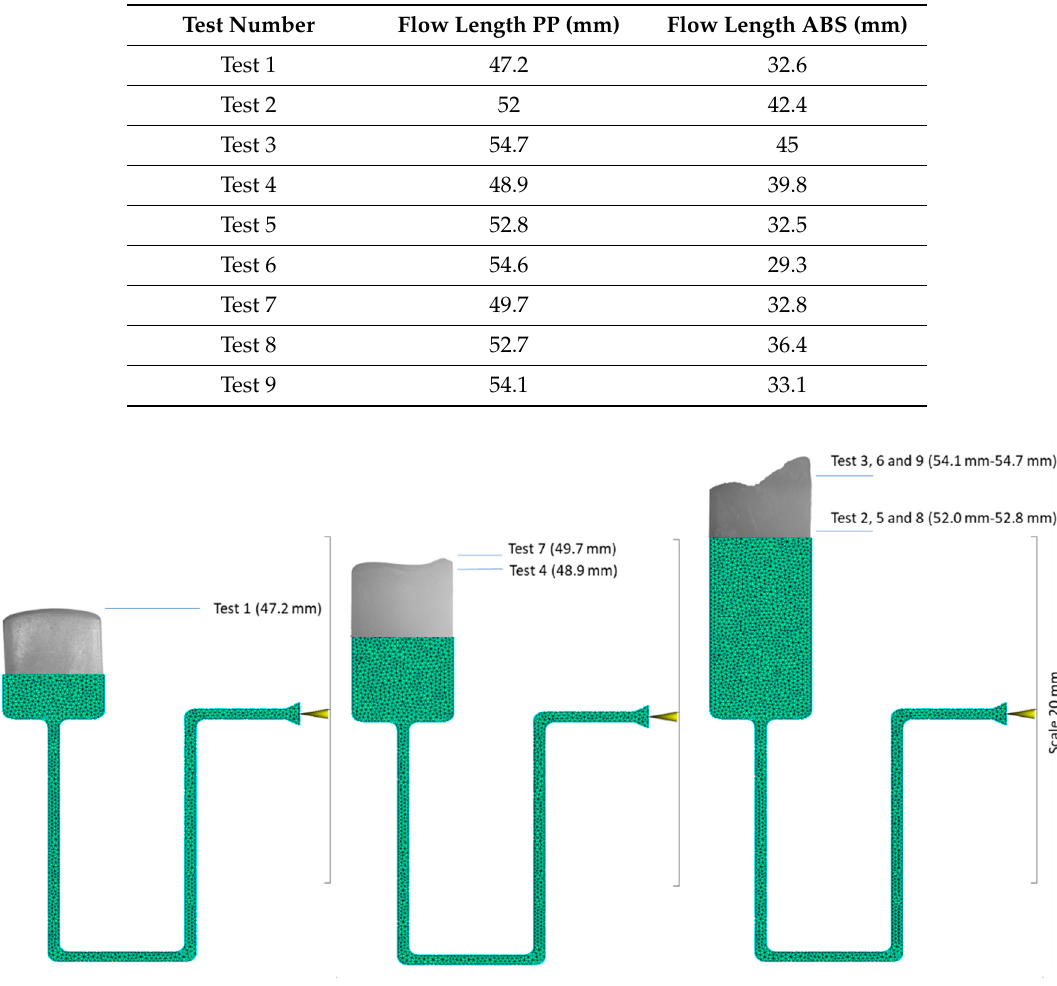
Figure 9. PP flow lengths for physical Tests 1-9.